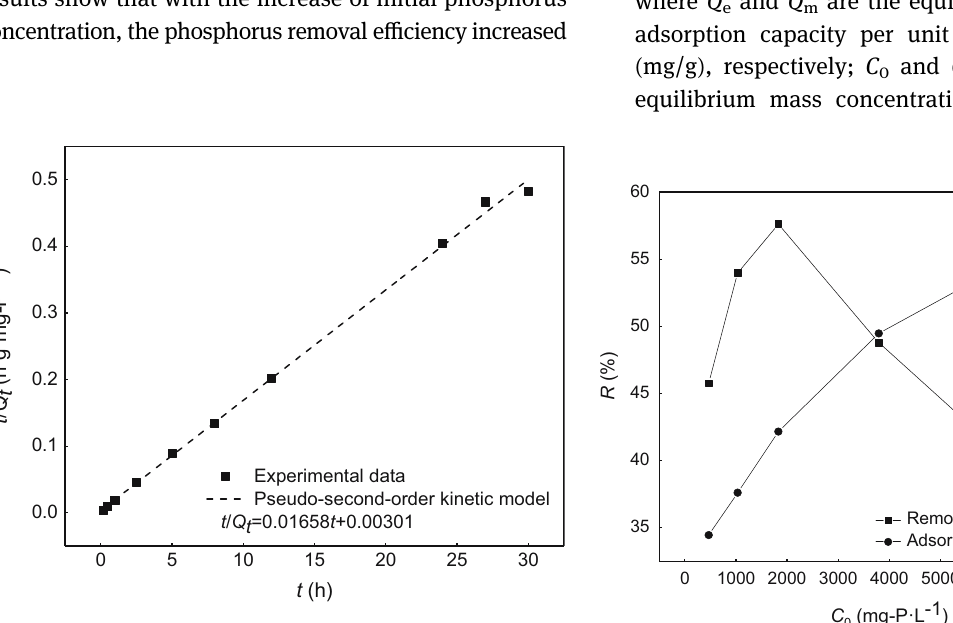
Figure 6: The pseudo - second - order kinetic fi tting for phosphorus adsorption on synthetic